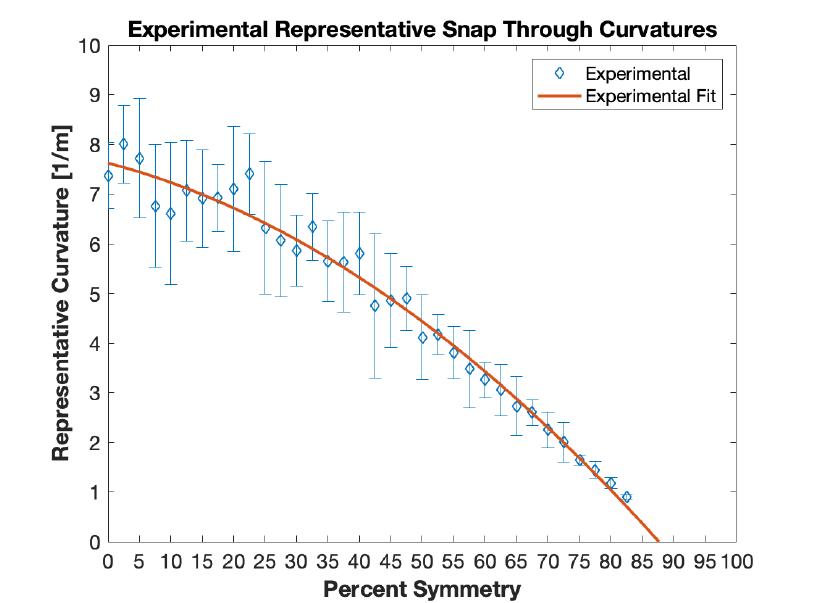
Figure 10. The representative snap through curvature versus the percent symmetry.